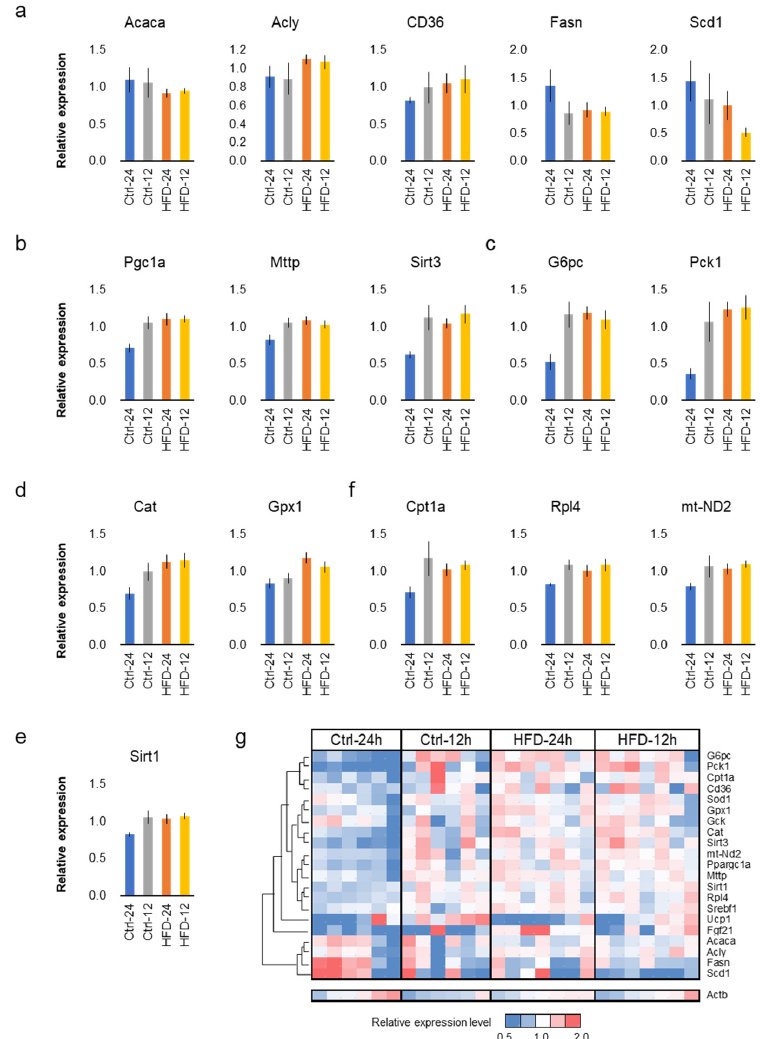
Figure 6. Hepatic gene expressions in SAMP8: hepatic gene expressions at 16 m-old associated with lipid metabolism ( a ), mitochondrial function ( b ), glucose metabolism ( c ), antioxidant ( d ), and anti-stress ( e ). Genes upregulated only by night-time-restricted feeding (NtRF) ( f ). Expression levels of all the 22 genes analyzed were visualized by heatmap with hierarchical clustering ( g ). The results of all the measured genes and statistics are shown in Supplementary Table